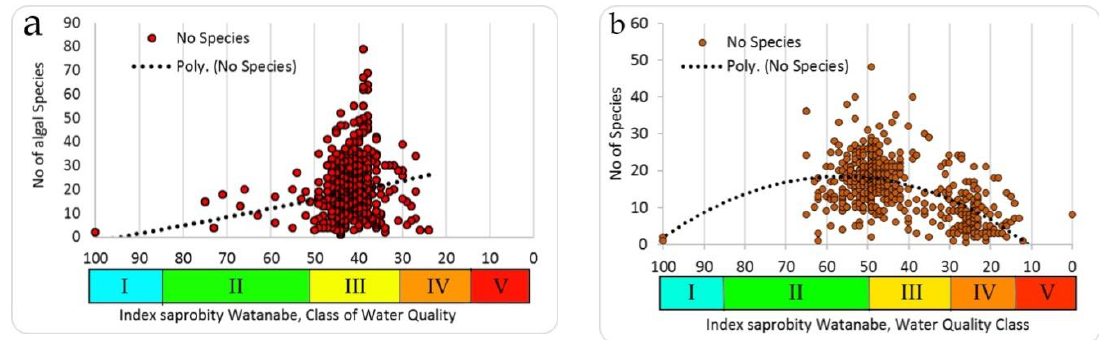
Figure 8. Distribution of species richness in algal communities ( a ) and consumers ( b ) over the Watanabe saprobity index scale in the studied water bodies of Ukraine.